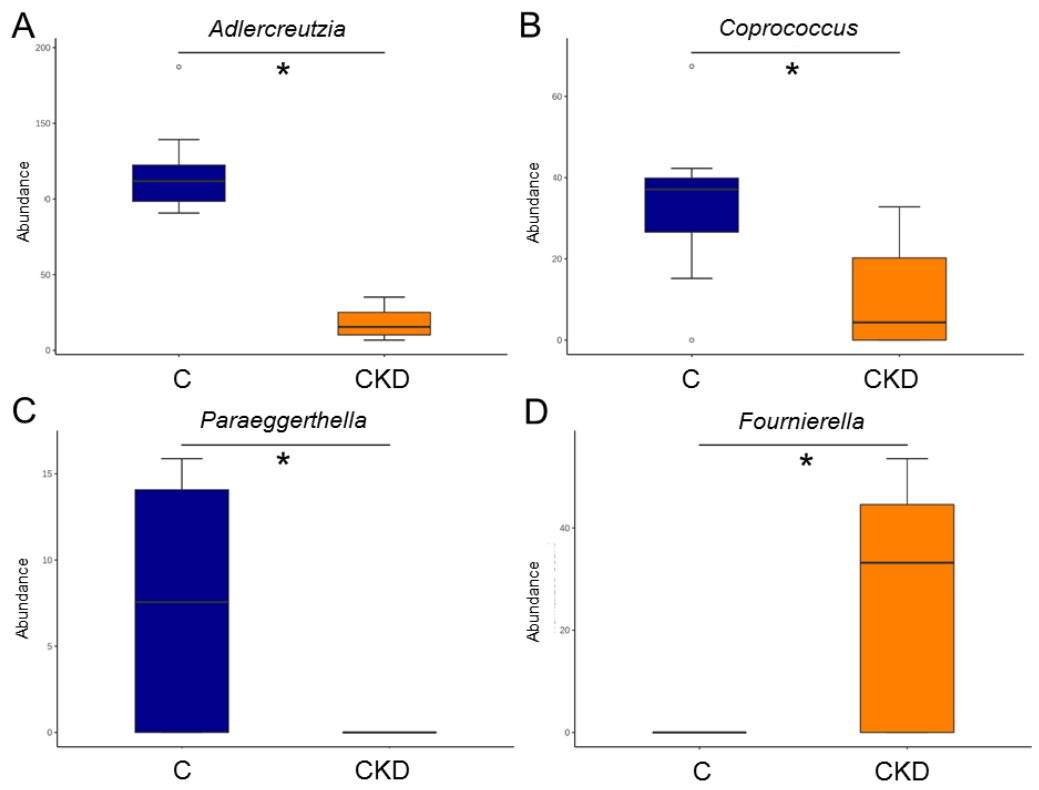
Figure 7. Effect of maternal CKD on the gut microbiota in 12-week-old male offspring. Genus-level relative abundance of ( A ) Adlercreutzia , ( B ) Coprococcus , ( C ) Paraeggerthella, and ( D ) Fournierella . * p < 0.05.